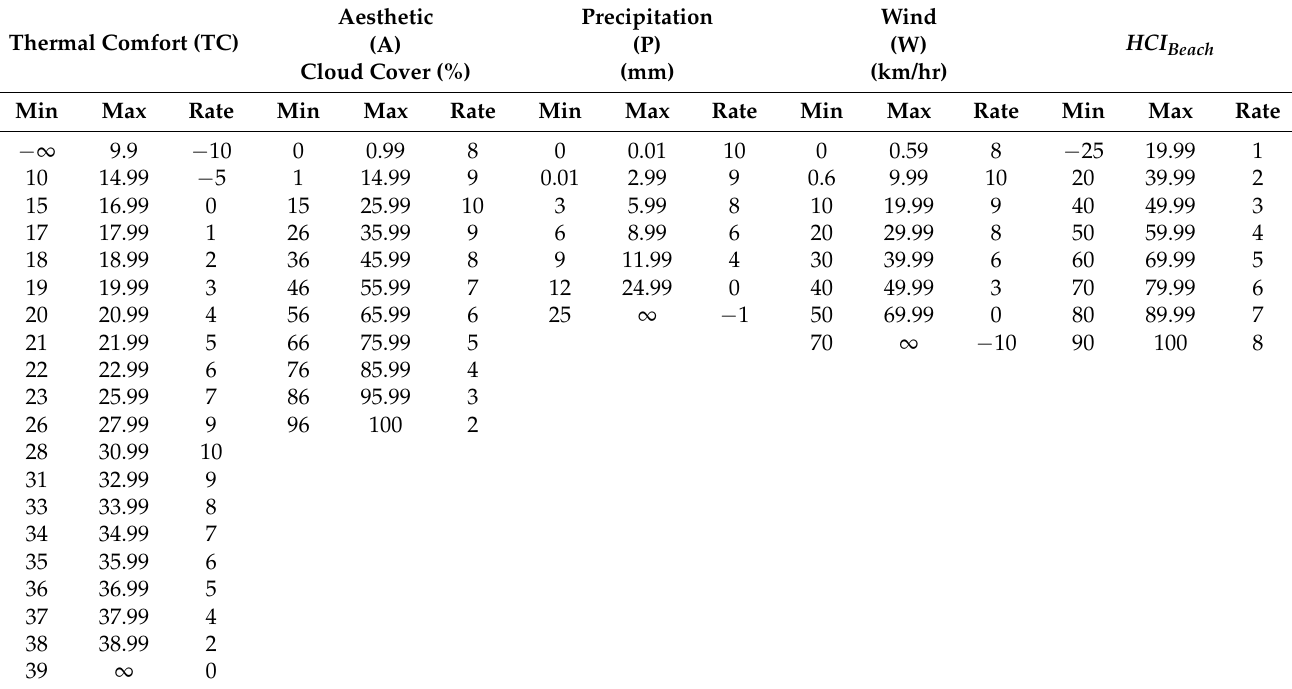
Table A1. The ratings of thermal comfort, aesthetics (according to cloud cover), precipitation, wind facets, and HCI beach